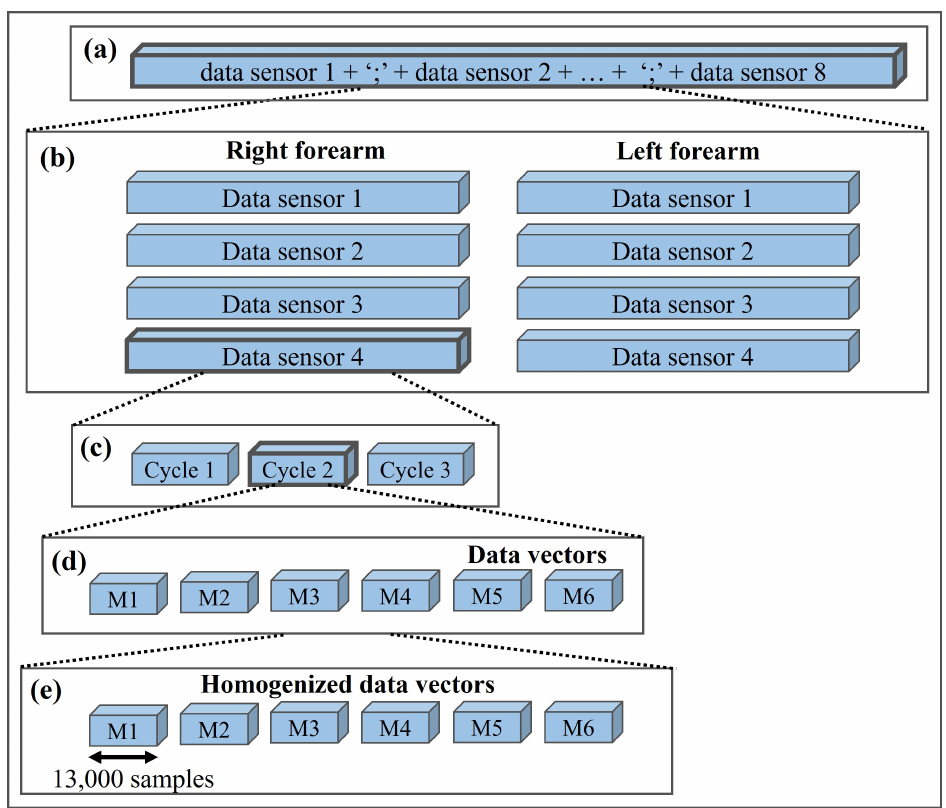
Figure 8. Schematic representation of the steps considered in the division algorithm. ( a ) DS j complete vector, ( b ) Division of the DS j vector into each of the eight sensors, ( c ) Division of each data sensor into each of the three cycles, ( d ) Division of each cycle into each of the six movements, ( e ) Homogenization of the each movement